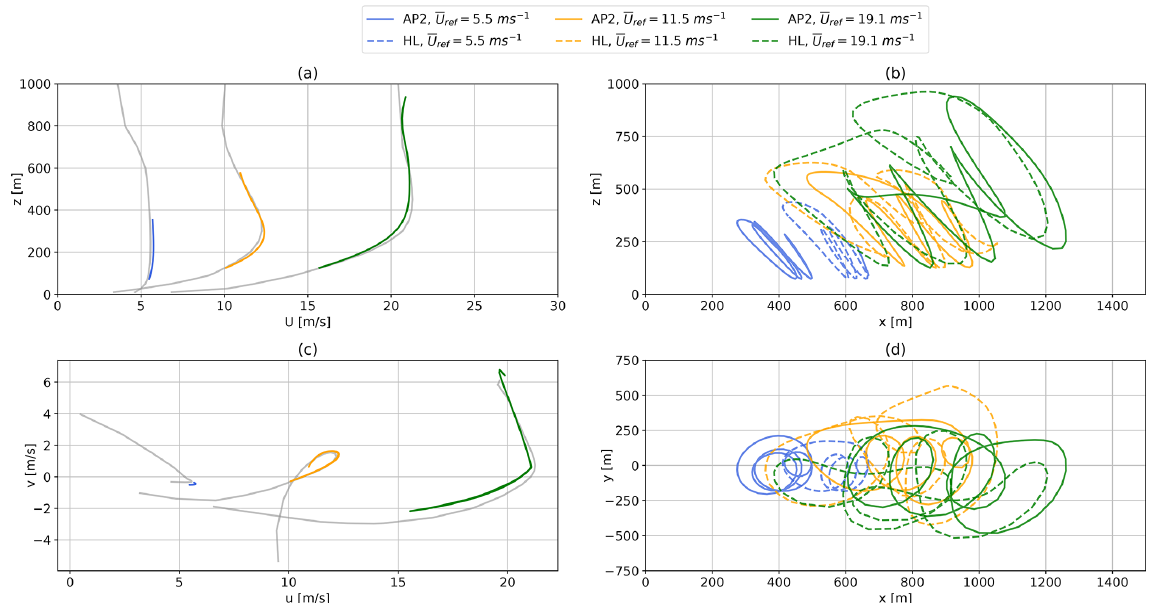
Figure 5. Optimization results of one pumping cycle for the ground-generation AWESs with a wing area of A = 50m 2 , mass scaling exponent κ = 3 for both AP2 reference (solid lines) and high-lift HL (dashed lines) aerodynamic coefficients at various WRF-generated wind conditions. Diagrams (a) and (c) depict representative horizontal onshore wind speed profiles and their hodographs of wind velocity up to 1000m. The deviation of the colored lines is caused by the implementation of discrete WRF-simulated data points using Lagrange polynomials. Diagrams (b) and (d) show the optimized trajectories in side and top